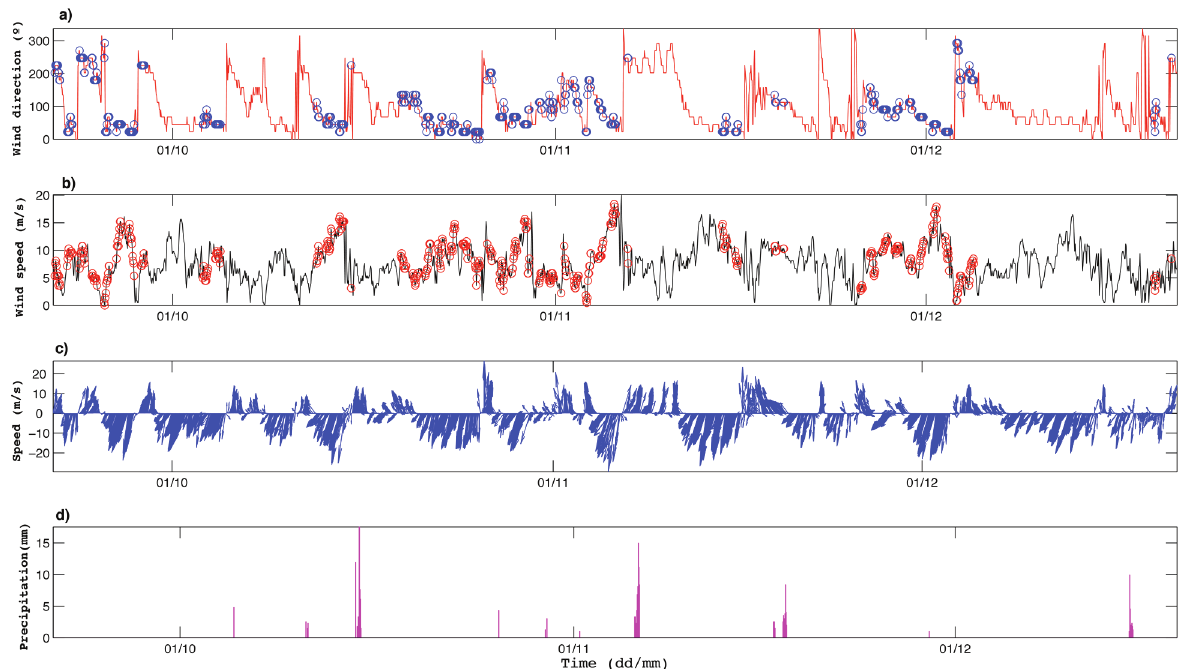
Figure 9 - Atmospheric data from the spring of 2006 collected from the Pilot Station ( a , b , c ) and the FURG meteorological station ( d ). The circles ( a , b ) show when ephemeral dunes were identified. ( a ) Wind direction. ( b ) Wind speed. ( c ) Wind direction, where north is a line pointing down ( d ) represents the rainfall accumulated per hour at the 2006 spring.